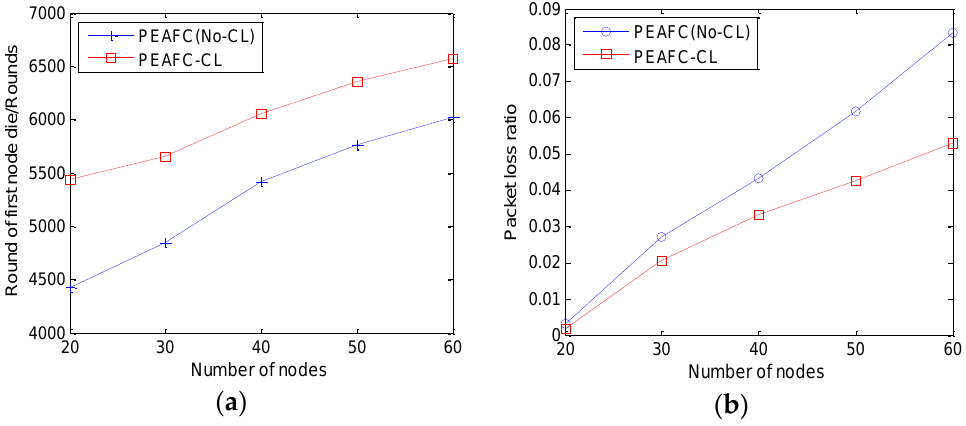
Figure 13. ( a ) Round when the first node dies vs. number of nodes; ( b ) Packet loss ratio vs. number of nodes.